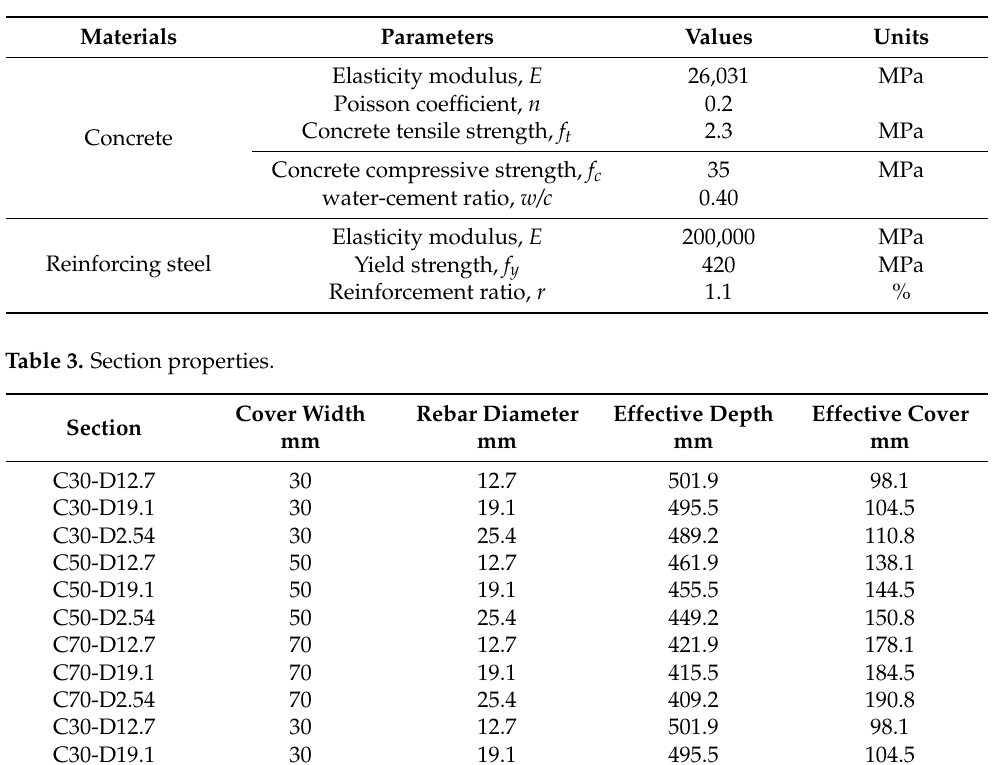
Table 2. Material properties.